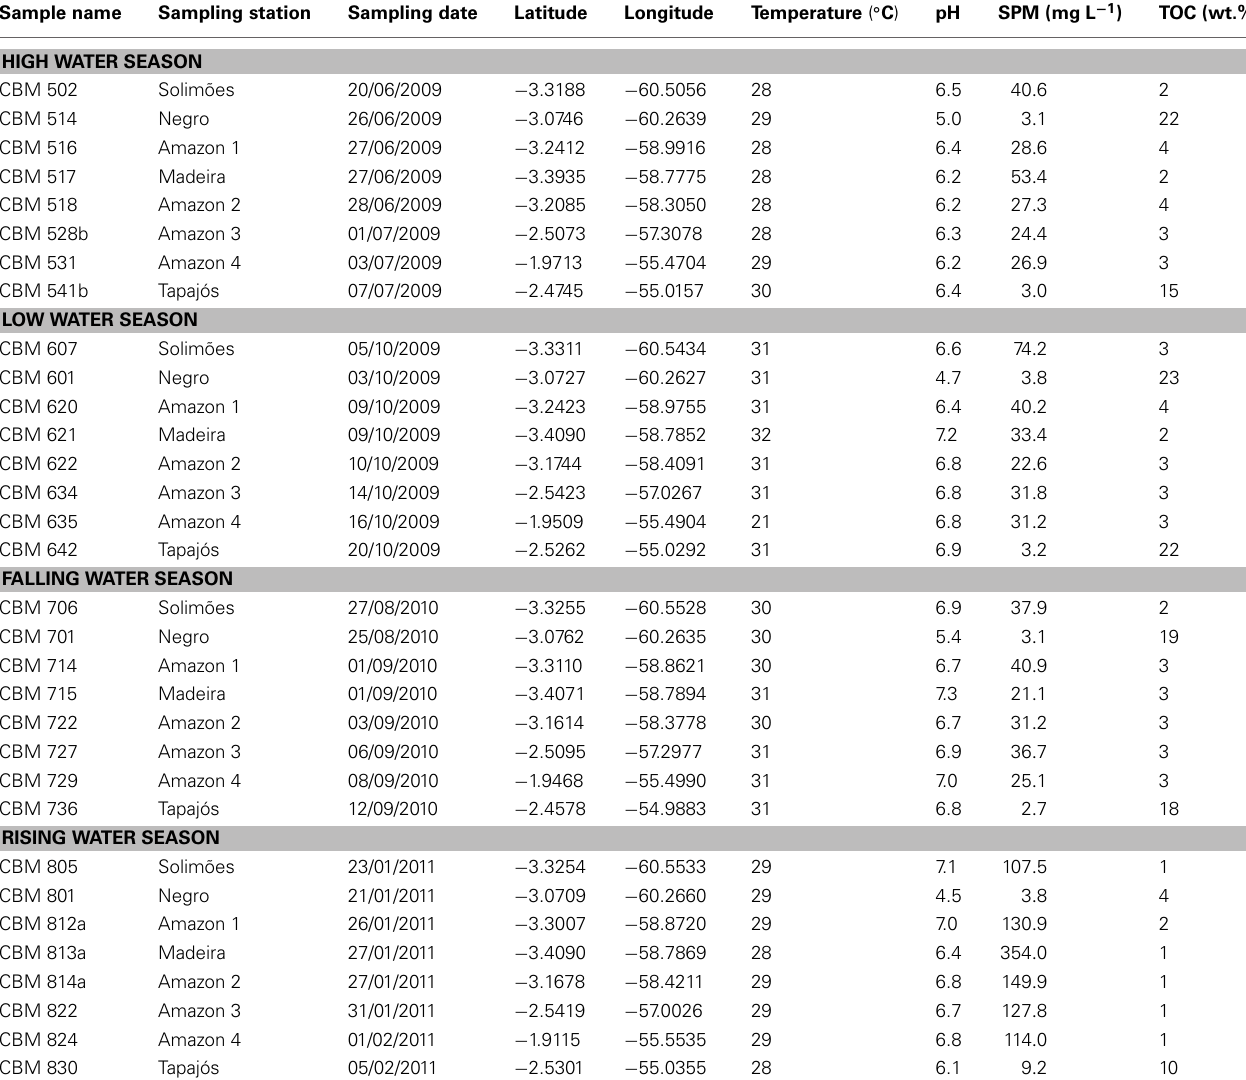
Table 1 | Sampling stations and environmental